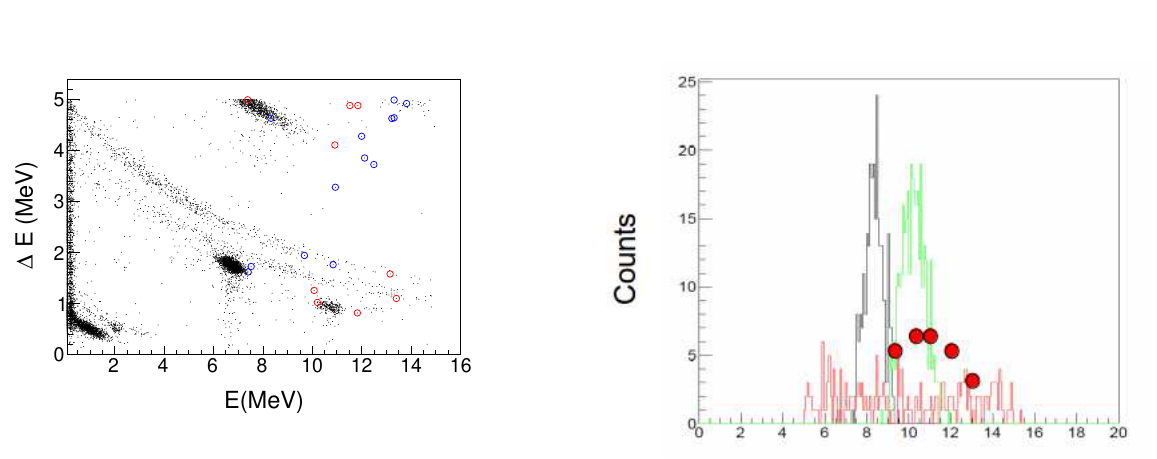
Figure 4. Δ E - E spectrum for 7 Be + nat Pb at 22.5 MeV. The spectrum, events denoted with black dots, is zoomed for Δ E ≤ 5 and is taken without any time window. The open circles in red and blue, denote reaction events with a time window to the 7 Be beam with di ff erent time bounces. The data refer to the three lower pixels of strip 27 of the DSSSD detector installed beam right, corresponding to θ lab ≈ 41 ◦ .